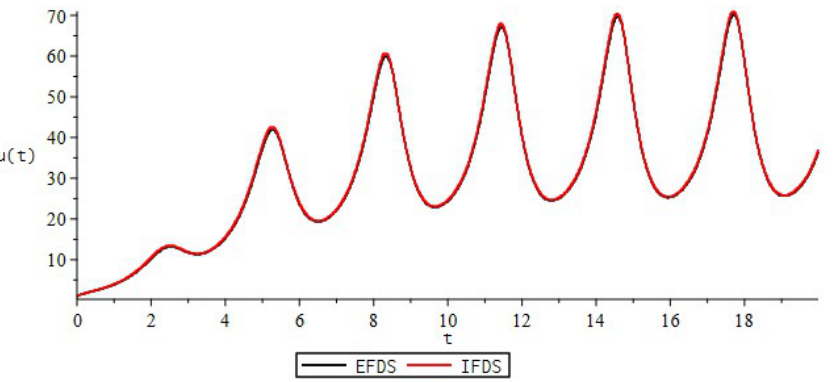
Figure 7. Numerical solutions of the fractional Riccati equation with variable coefficients α ( t ) = 0.4 + sin 2 ( t ) /2—periodic function. Table 5. Computational accuracy EFDS and IFDS, at T =